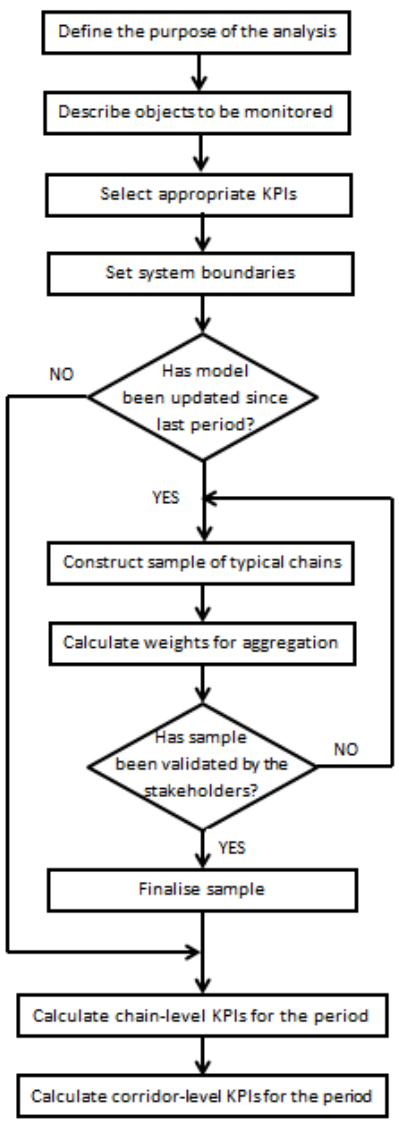
Figure 1. Flow diagram of the proposed